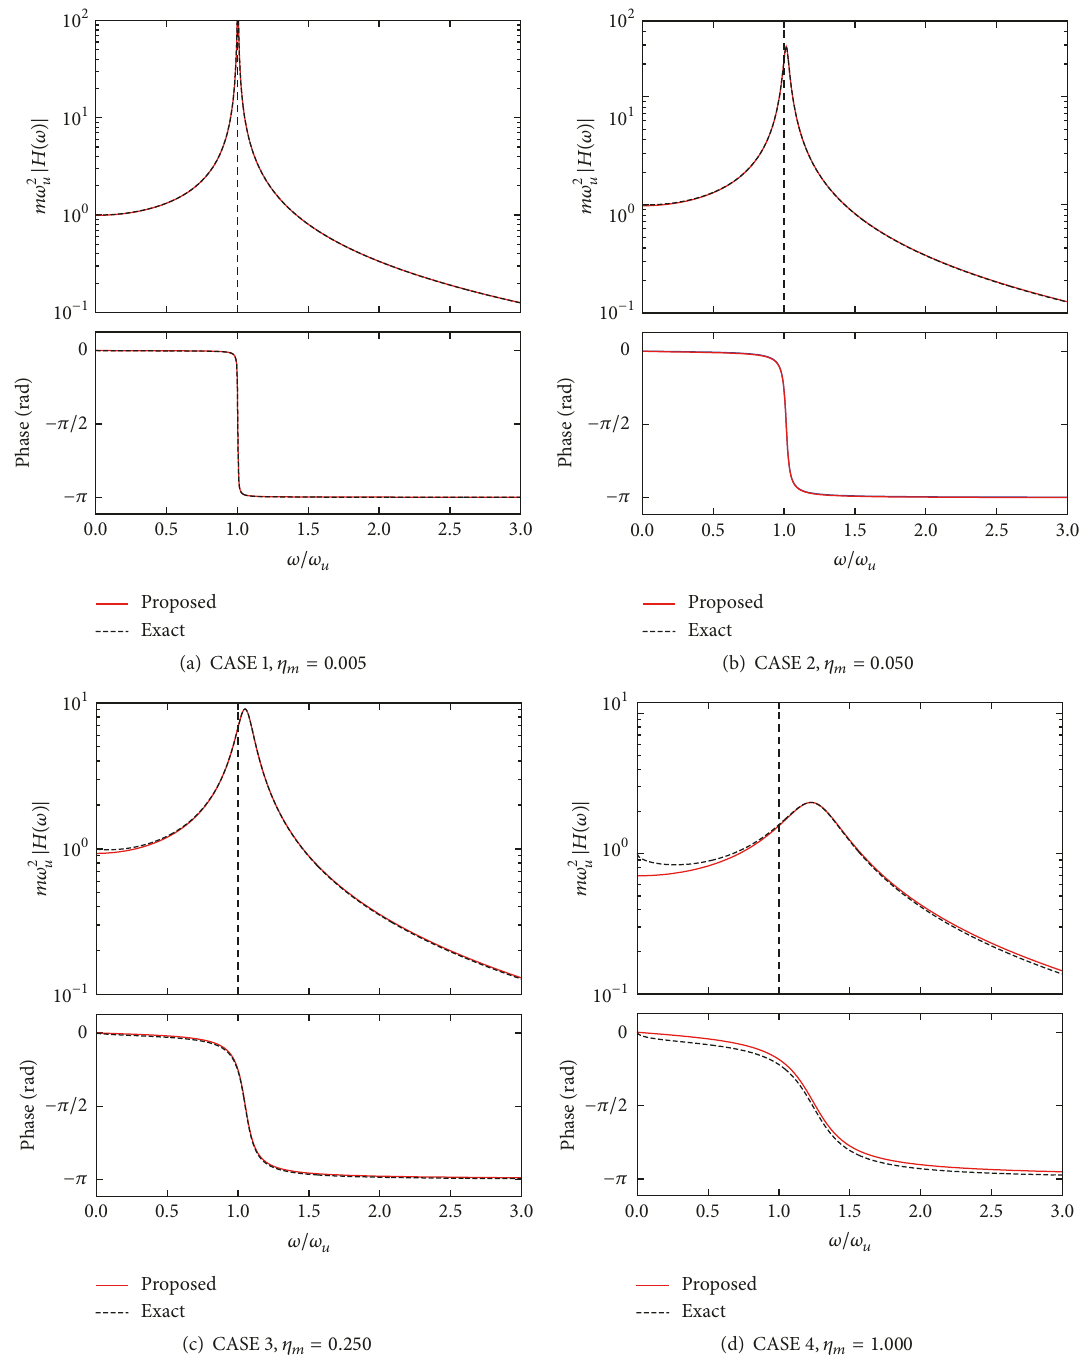
Figure 2: Example 1: single-degree-of-freedom system. Frequency response functions of viscoelastic (exact) and viscous (proposed) system. The four cases covered in Table 1 are represented from plots (a) to (d), respectively. Table 2: Example 2: viscoelastic 1D structures. Viscoelastic material and beam model mechanical properties. The reference frequency is 𝜔 = √ 𝐸𝐼 /𝜌𝐴𝐿 4 , where 𝐴 and 𝐼 0 𝑦 𝑦 are, respectively, cross-sectional area and moment of inertia.